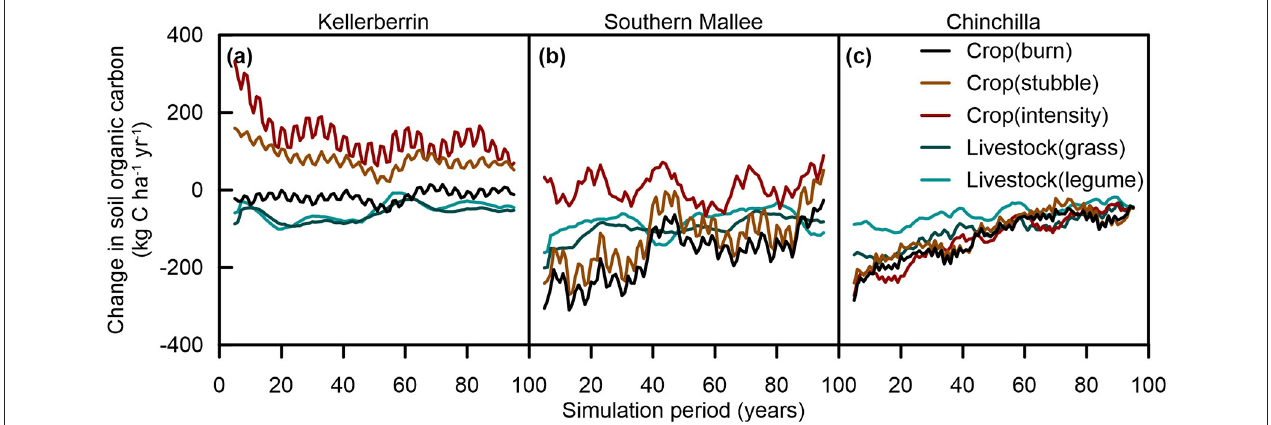
FIGURE 6 | Average change in soil organic carbon ( 1 SOC) for the cropping scenarios, Crop burn (burnt stubble), Crop stubble (retained stubble), and Crop intensity (increased cropping intensity), and livestock scenarios, Livestock grass (permanent grass pasture) and Livestock legume (permanent improved pasture), at the (a) Kellerberrin, (b) Southern Mallee, and (c) Chinchilla case study